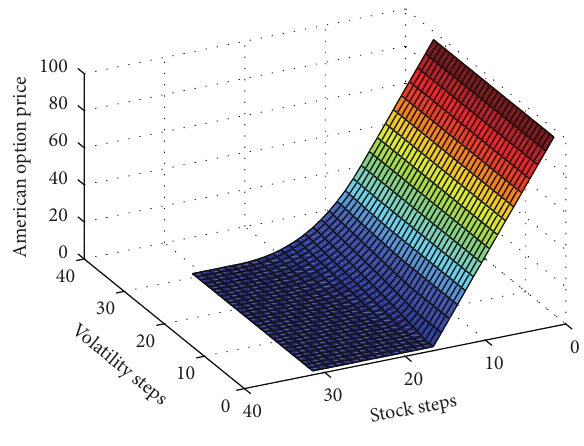
Figure 3: American option price under different